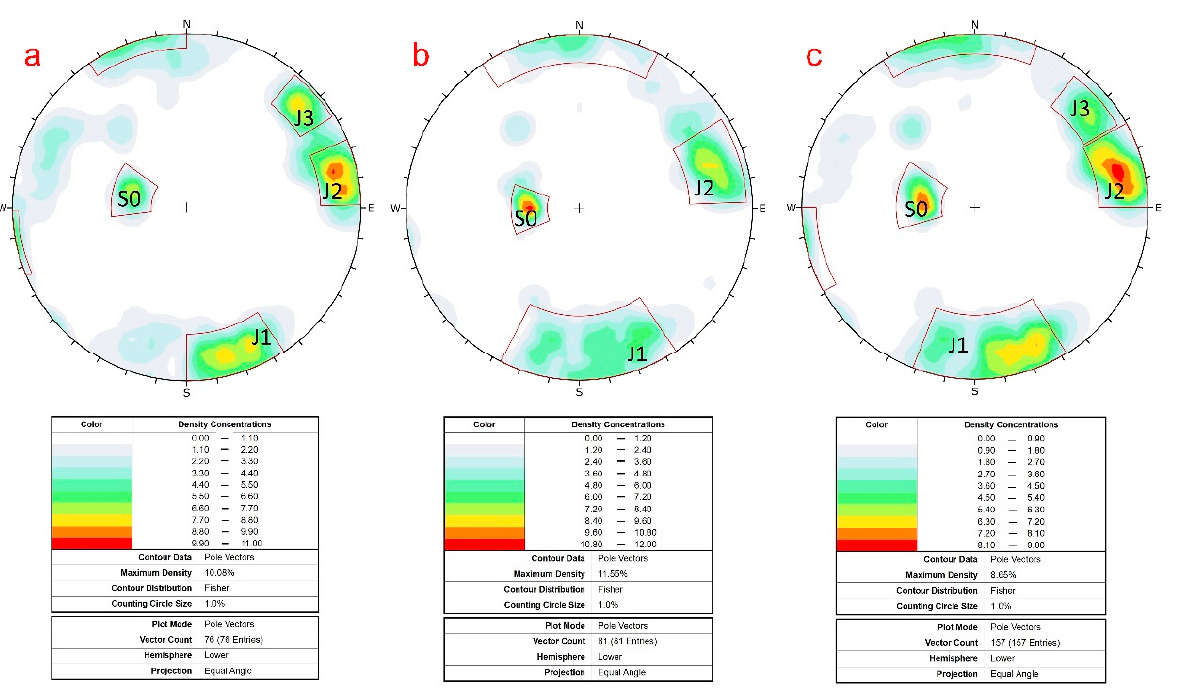
Figure 6. Lower hemisphere stereonet plots of discontinuity poles measured from: ( a ) engineering geological mapping, ( b ) photogrammetric surveys, ( c ) combination of engineering geological mapping and photogrammetric surveys.